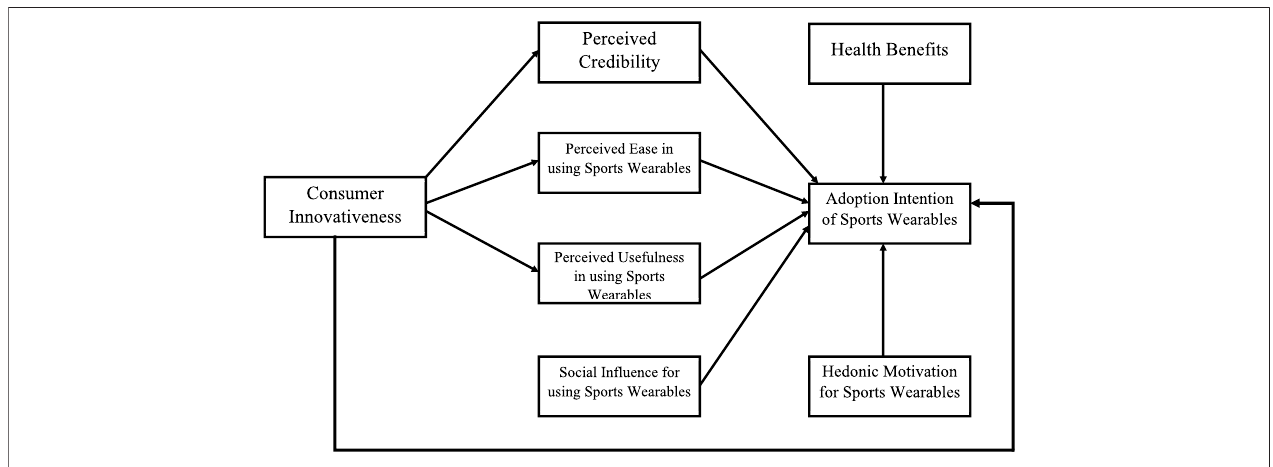
FIGURE 1 | Framework of the